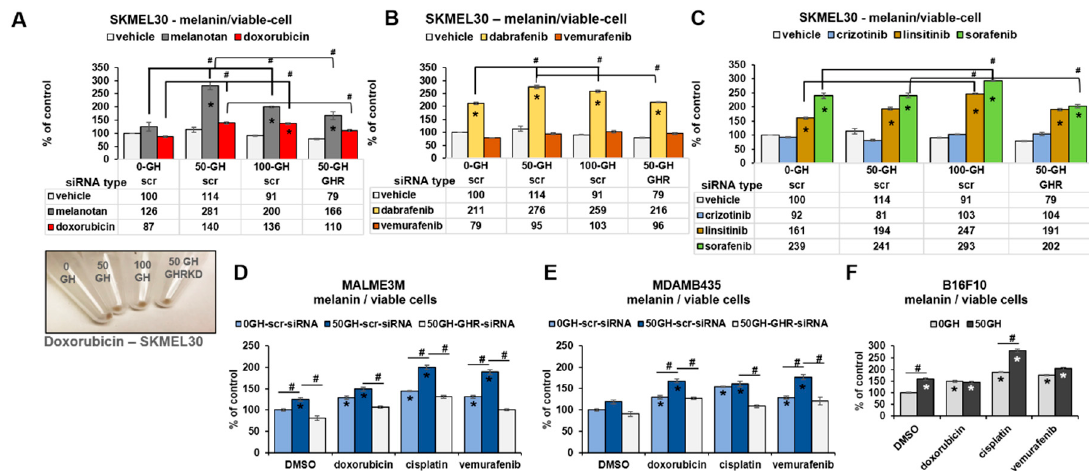
Figure 4. GH enhances MITF regulated melanogenesis activity in human melanoma cells. Changes in amounts of melanin formed inside SK-MEL-30 cells following treatment with di ff erent treatments for 72 h in presence of 0, 50, 100 ng / mL recombinant human growth hormone as well as siRNA-mediated GHR knockdown (GHRKD) in presence of 50 ng / mL GH was analyzed. ( A ) alpha-MSH analog melanotan (100 nM), doxorubicin (1 µ M); ( B ) mutant BRAF targeted therapeutics—vemurafenib (2 µ M), and dabrafenib (3 µ M); or ( C ) tyrosine kinase inhibitors—linsitinib (5uM), crizotinib (10 µ M), sorafenib (5 µ M) were used. Similar treatments with doxorubicin, cisplatin, and vemurafenib was done with BRAF-mutant cell-lines MALME-3M ( D ) and MDA-MB-435 ( E ) as well as the mouse melanoma cell line B16F10 ( F ). Cell pellets were dissolved by heating in NaOH and absorbance was measured at 450 nm. Reads were normalized by cell counts at the end of 72 h treatments. Inset shows cell pellets from doxorubicin treatment. Data represents mean +/ − SD. Student’s t -test was performed using MS-EXCEL to identify significant di ff erences at p < 0.05. (#,*, p < 0.05, Students t test, n = 3; * indicates comparison against untreated (-GH, -dox, -GHRKD)